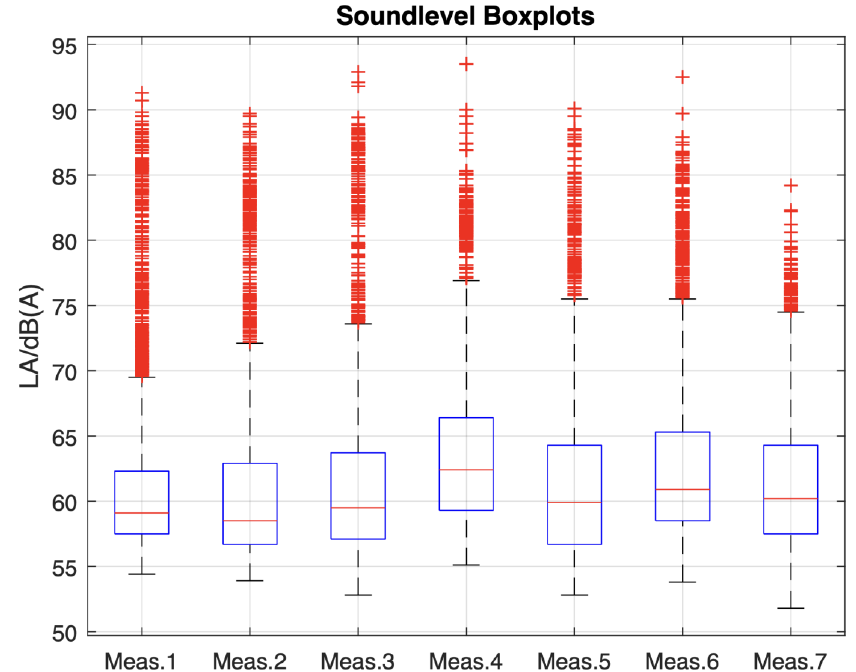
Figure 2. Boxplot of the sound levels in dB(A) during the investigated TKA